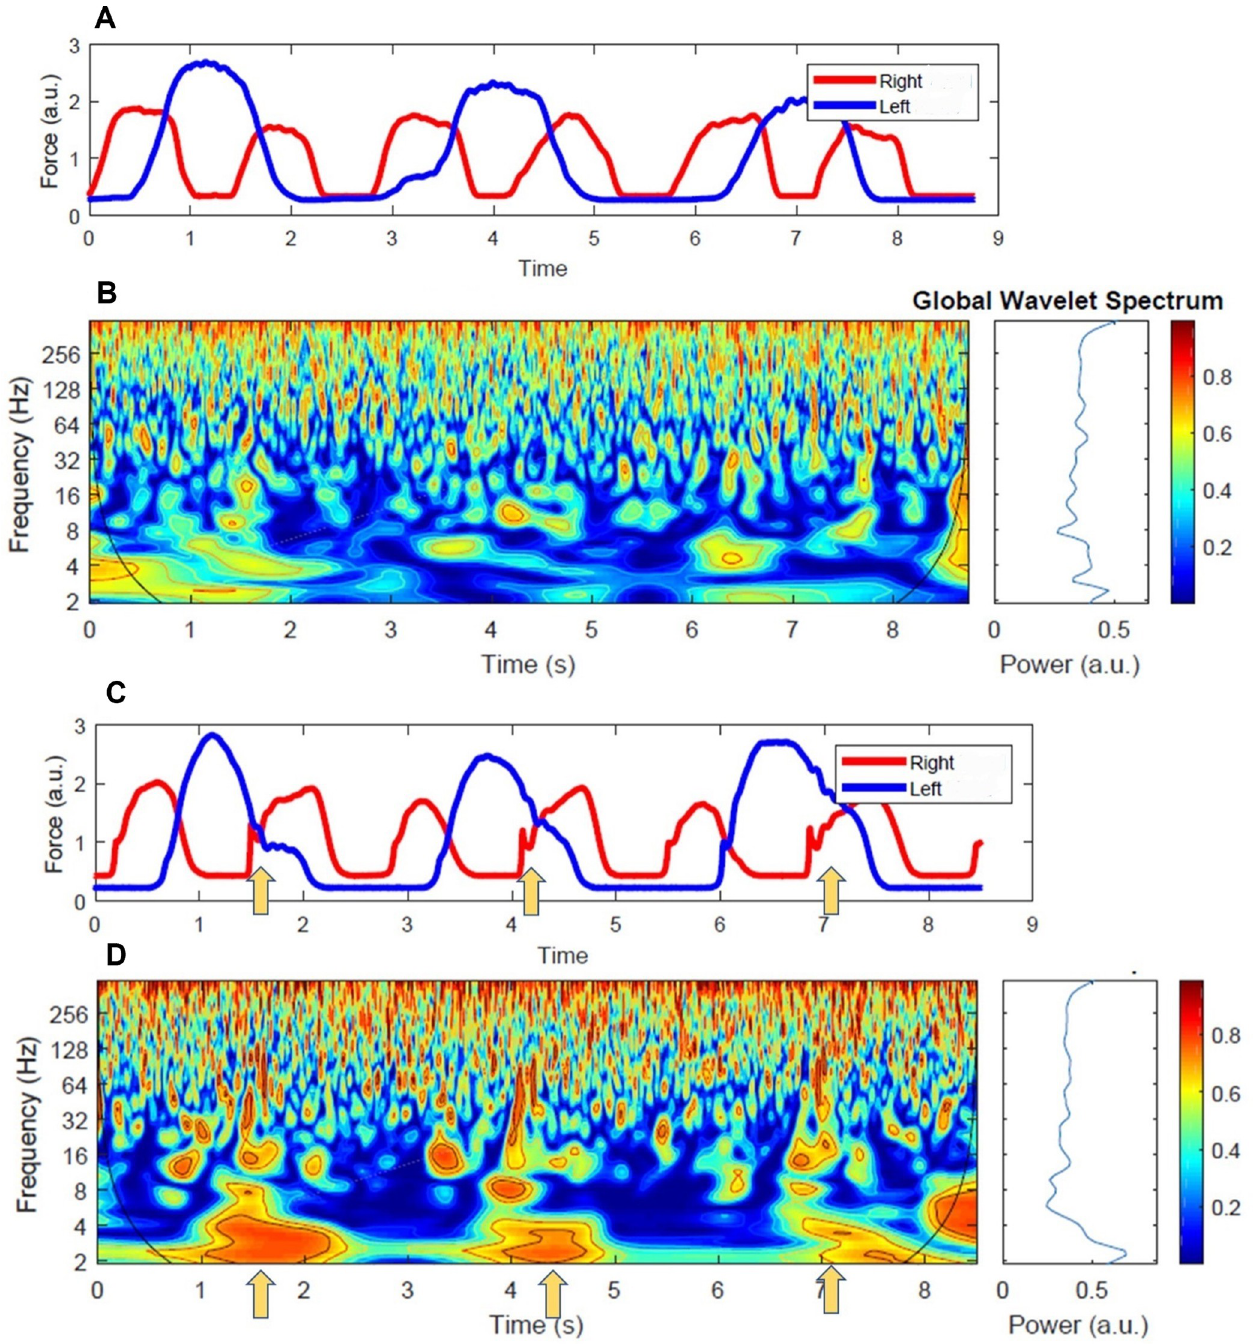
Fig 7. EMG analysis. (a) Sample non-dominant and dominant distal (FDI) effector EMG Amplitude, (b) the corresponding EMG-EMG Wavelet Spectrum for distal effector. (c) Sample non-dominant and dominant proximal (TBI) effector EMG Amplitude, (d) the corresponding EMG-EMG Wavelet Spectrum for proximal effector. Note, the arrows indicate areas where high coherence occurred relative to behavior and the color code represents the strength of the coherence on a scale of 0 (blue) to 1 (red).